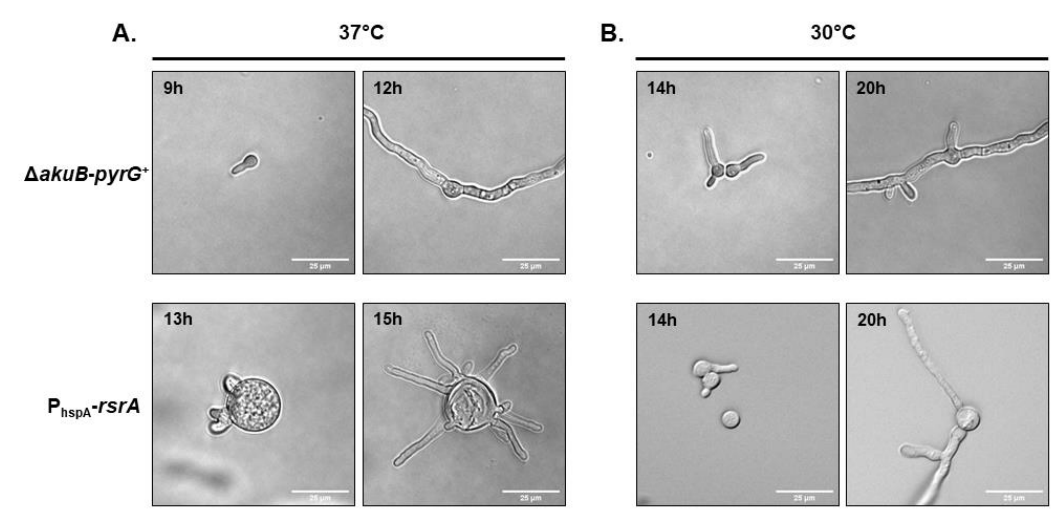
Figure 3. Overexpression of rsrA produces a defect in patterning of polarity establishment. Depicted are time course microphotographs showing the development of control and P hspA - rsrA strains. Two thousand conidia were cultured in liquid GMM and incubated at 37 °C ( A ) or 30 °C ( B ) and microphotographs were taken at the indicated time points.